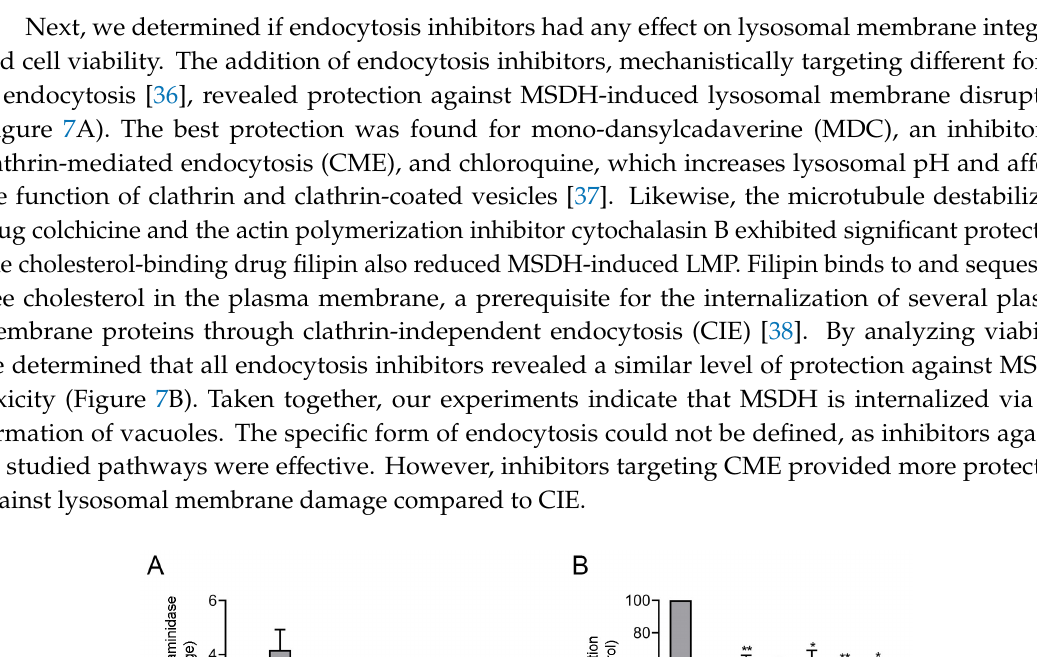
Figure 6. Enhanced endocytosis after exposure of fibroblasts to MSDH. Electron micrograph of fibroblasts exposed to 15 μM MSDH; ( A ) control ( B ) 5 min exposure, and ( C ) 15 min exposure. Arrows indicate small well-defined vacuoles with protein coat at the edge of the cell and arrowheads indicate larger vacuoles without protein coat. Magnification 40,000× and scale bar 1 μm.